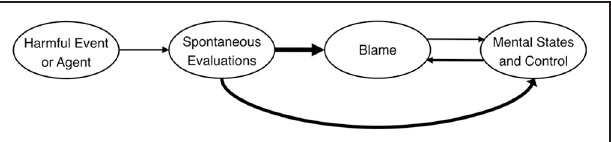
FIGURE 2 | Implied graphical representation of Alicke’s culpable control